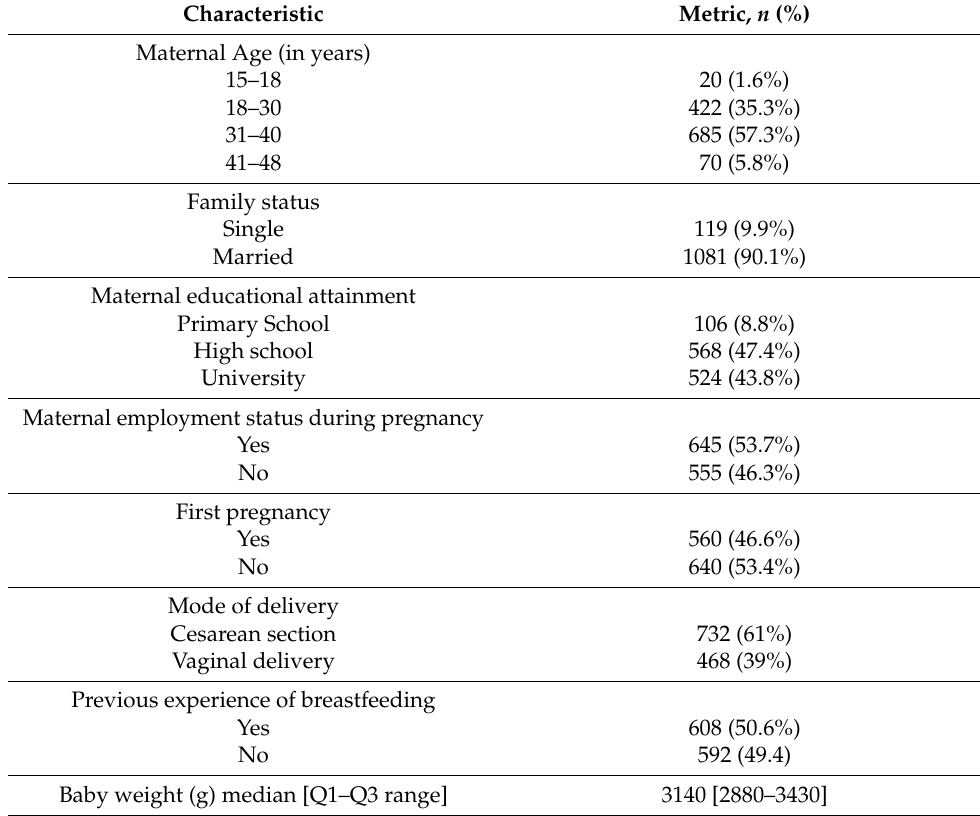
Table 1. Characteristics of mothers and infants in the study.